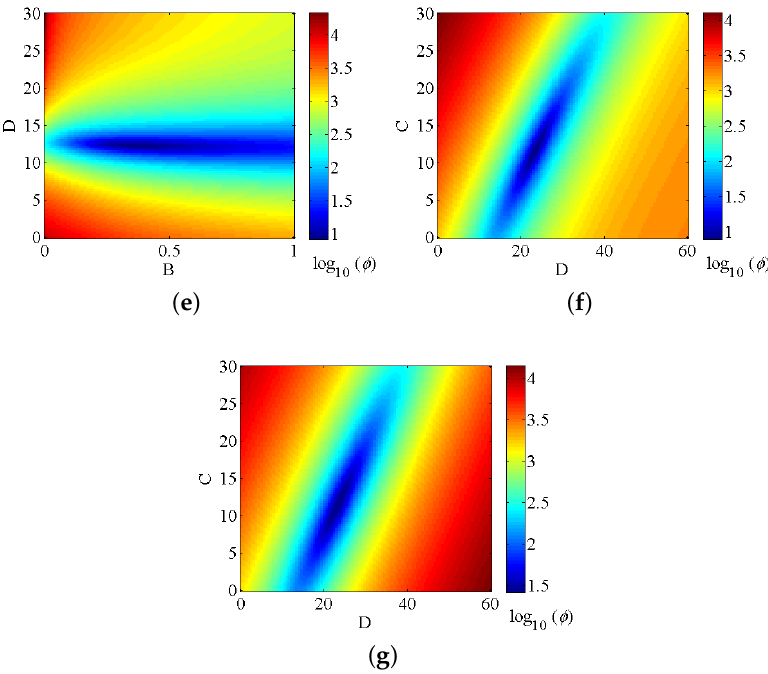
Figure 2. Response surface of the objective function in the ( a ) A–B, ( b ) A–C, ( c ) A–D, ( d ) B–C, (e) B–D and ( f ) C–D plans for the first calibration methodology for the VV polarization; ( g ) the C–D plan